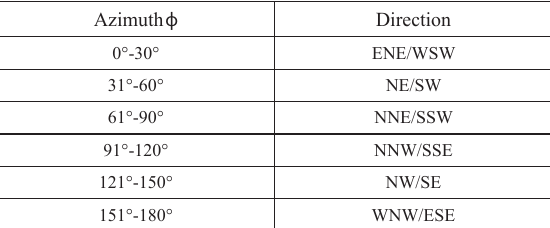
Intervals of bi-directional